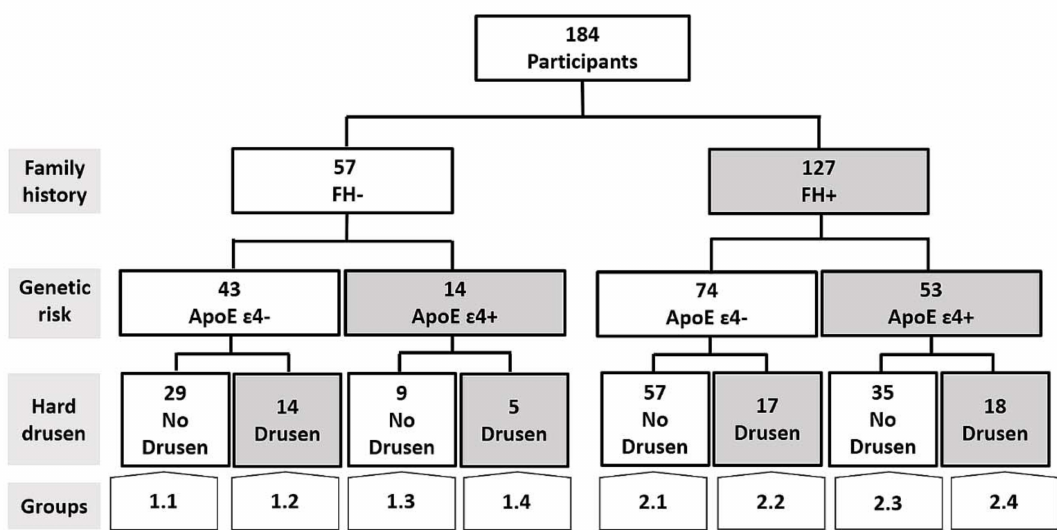
Figure 1. Flow diagram of the patients included in the present work. FH+: subjects with a family history of Alzheimer’s disease (AD); FH − : Subjects without a family history of